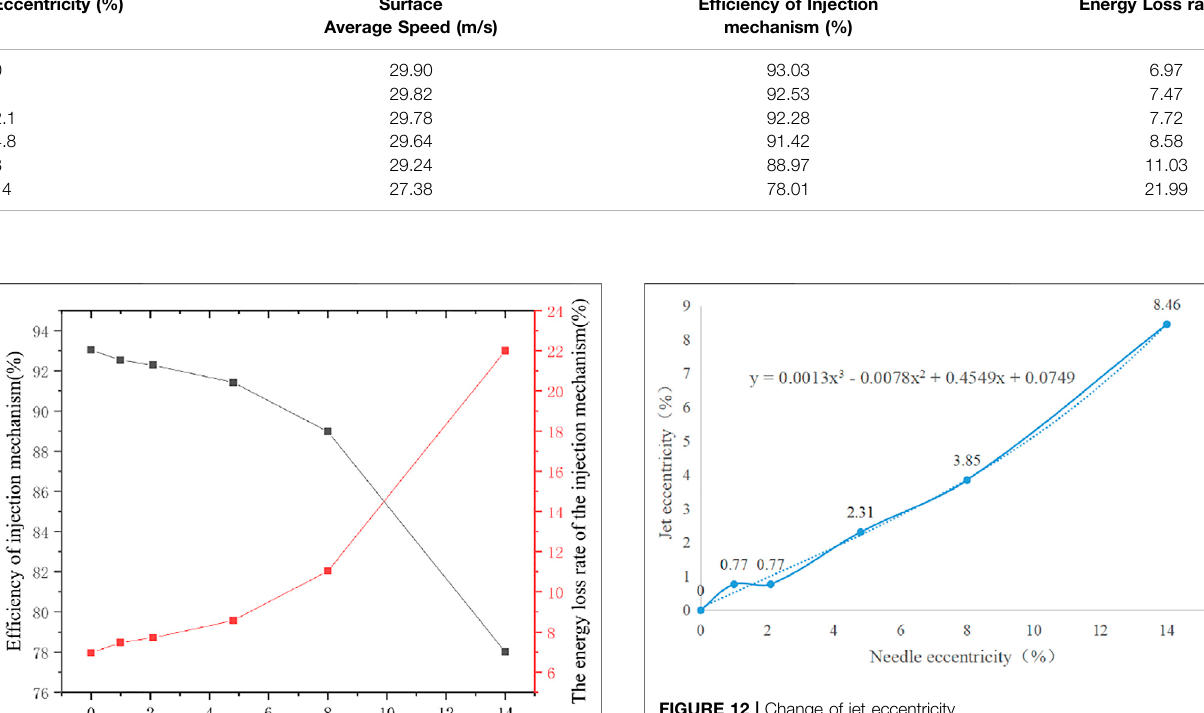
TABLE 3 | The ef fi ciency and energy loss of the injection mechanism under different working conditions. Eccentricity (%)